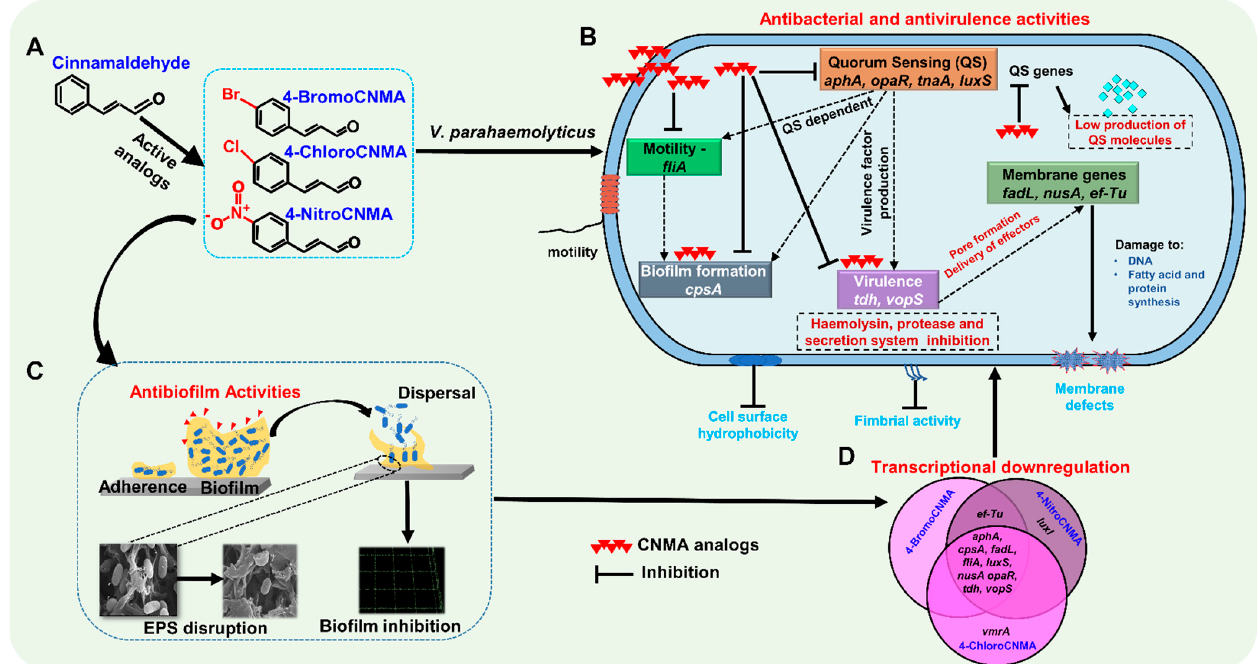
Figure 7. Proposed mechanism of antibacterial, antibiofilm and antivirulence actions of CNMA derivatives against V. parahaemolyticus . Active CNMA analogs ( A ) violate the cell wall as well as interfere with quorum-sensing regulators, biofilm formation, surface adherence factors, motility, protease, toxin production, type III secretion system, and DNA repair in V. parahaemolyticus ( B , C ). It is envisaged that the repression of responsible QS and virulence genes ( D ) explains the mechanism behind the antimicrobial efficacies of CNMA analogs.